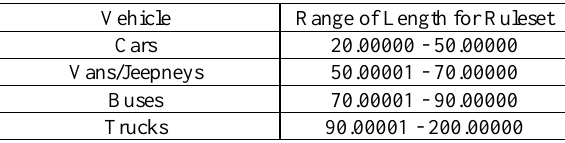
Table 2. Range of Length for Ruleset per Vehicle Type